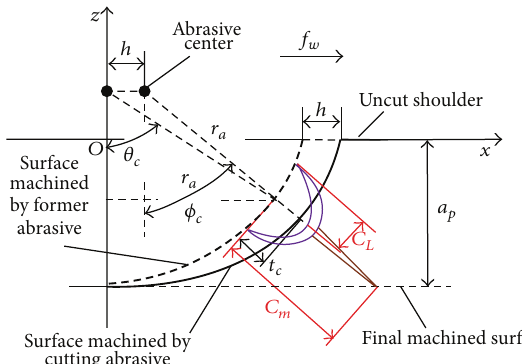
Figure 6: Geometry of critical undeformed chip thickness (𝑡 𝑐 ) of ductile